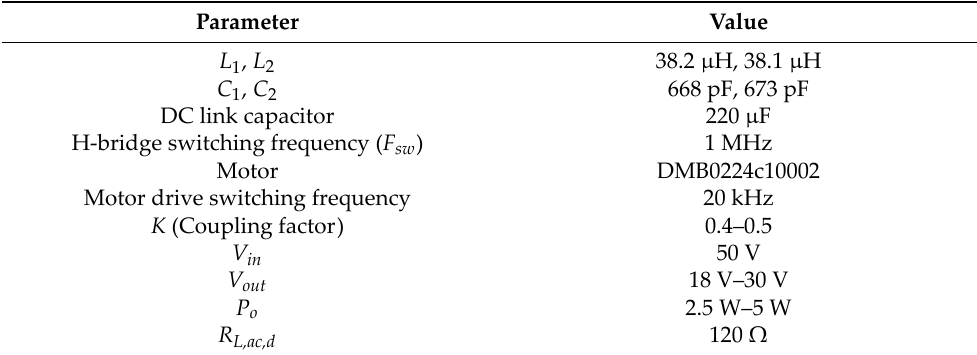
Table 1. System parameters.